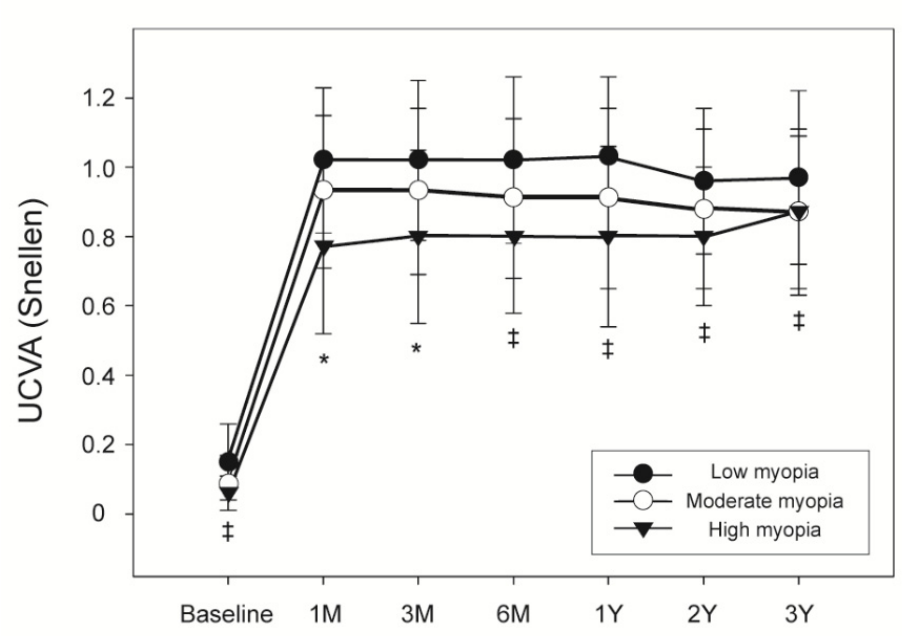
Figure 3. Comparison of pre- and postoperative uncorrected visual acuity according to the degree of myopia. *: significant difference among the three myopia groups ( p < 0.050); ‡: significant difference between the low and moderate myopia groups, and between the low and high myopia groups ( p < 0.050). UCVA = uncorrected visual acuity.